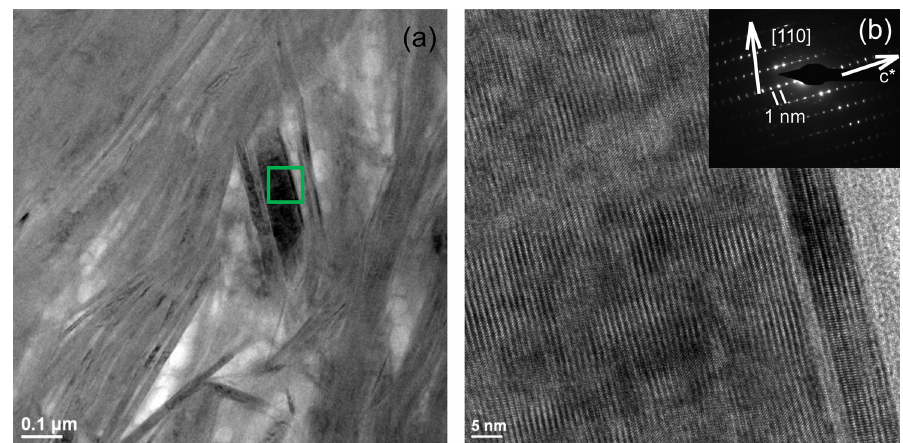
Figure 6. TEM images corresponding to celadonites: (a) low-magnification image of long celadonite crystals forming aggregates; (b) detail of the green square corresponding to a celadonite crystal composed of more than 50 layers with a spacing of 1nm as the selected area electron diffraction (SAED) pattern corroborates. Polytype 1 M can be identified both in SAED and high-resolution TEM